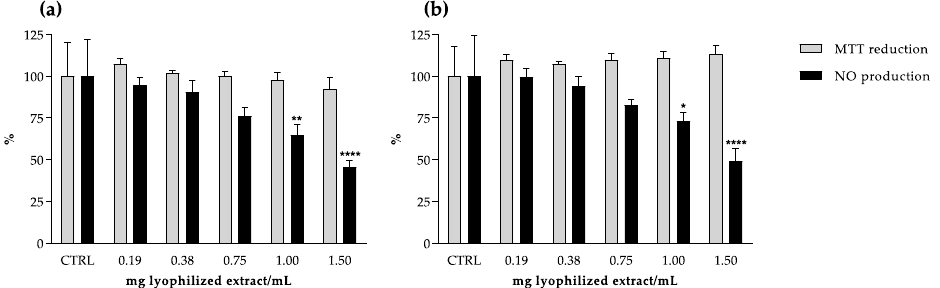
Figure 3. Effect of camel grass aqueous ( a ) and hydroethanol ( b ) extracts on thiazolyl blue tetrazolium bromide (MTT) reduction and nitric oxide (NO) production in lipopolysaccharide (LPS)-stimulated RAW 264.7 cells. Results are expressed as percentage of the respective control (CTRL) (mean ± SD of four determinations, each performed in triplicate). * p < 0.05; ** p < 0.01; **** p < 0.0001 (ANOVA, Tukey HSD multiple comparison test).